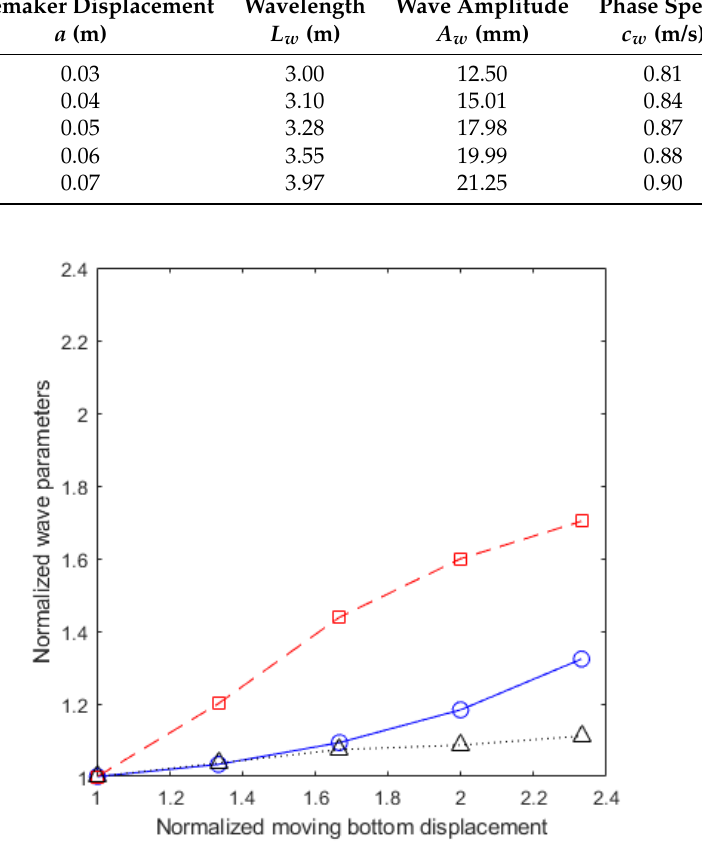
Table 2. Effects of vertical displacement of movable segment, a : wave parameters of leading elevation waves due to wavemakers of varying lengths. Bottom motion is given in (1) with L = 1 m and b = 0.5 s and the constant water depth is h 0 = 0.05 m. Records of free-surface elevation at the hinge are plotted in Figure 8. Wavemaker Displacement Wavelength Wave Amplitude